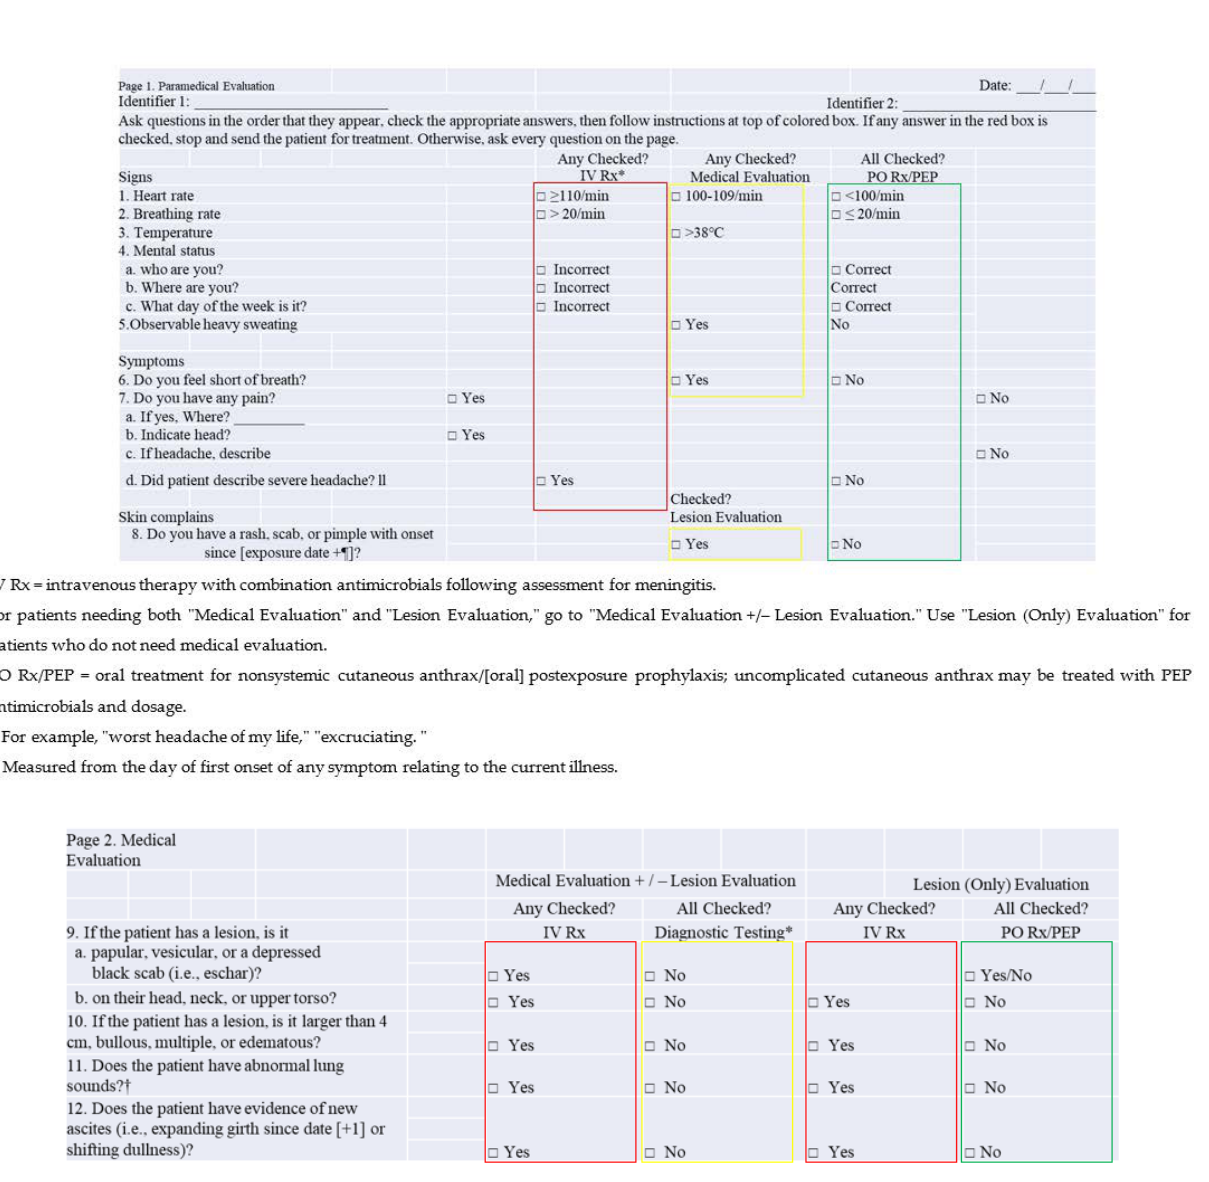
Figure 10. Checklist for initial triage after an anthrax mass-exposure event. Page 1: IV Rx (www.ncbi.nlm.nih.gov/pmc/articles/PMC5034857 accessed on 25 January 2022); PO Rx/PEP (www.ncbi.nlm.nih.gov/pmc/articles/PMC3901462 accessed on 25 January 2022); Page 2: U.S. Food and Drug Administration–authorized assay for Bacillus anthracis identification (https://wwwn.cdc.gov/ nndss/conditions/anthrax/case-definition/2018 accessed on 25 January